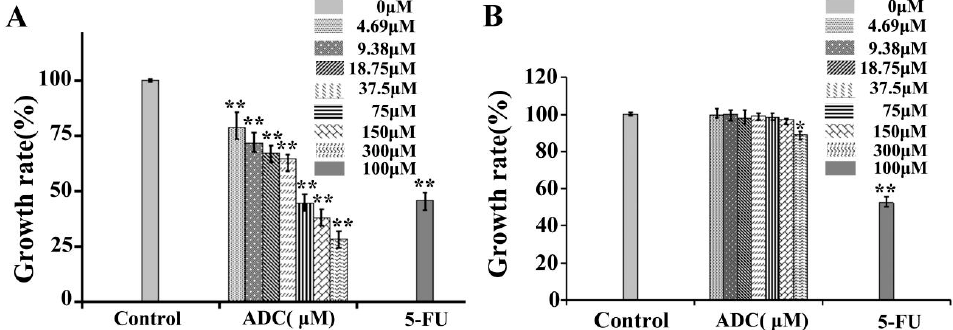
Figure 1. In vitro cell growth–inhibitory activity of ADC. SPCA-1 ( A ) and BEAS-2B ( B ) cell growth